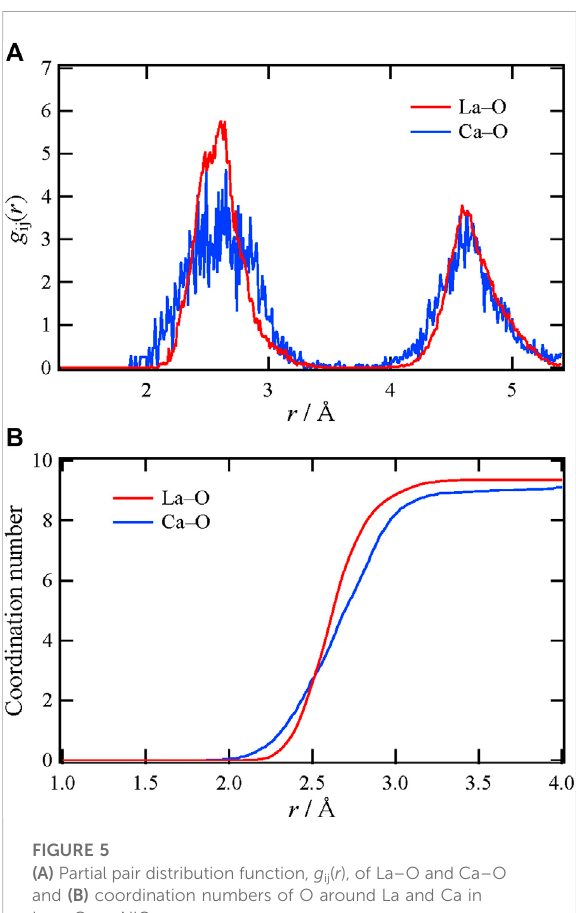
FIGURE 5 (A) Partial pair distribution function, g ij ( r ), of La – O and Ca – O and (B) coordination numbers of O around La and Ca in La 1.75 Ca 0.25 NiO 4+ δ